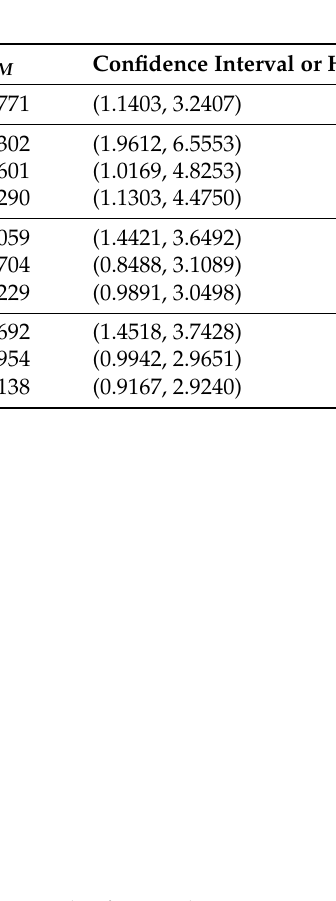
Figure 2. The quantile-to-quantile plot based on the complete sample of Example 2. Table 5. Waiting time data of customers before receiving service in the bank (in minutes).